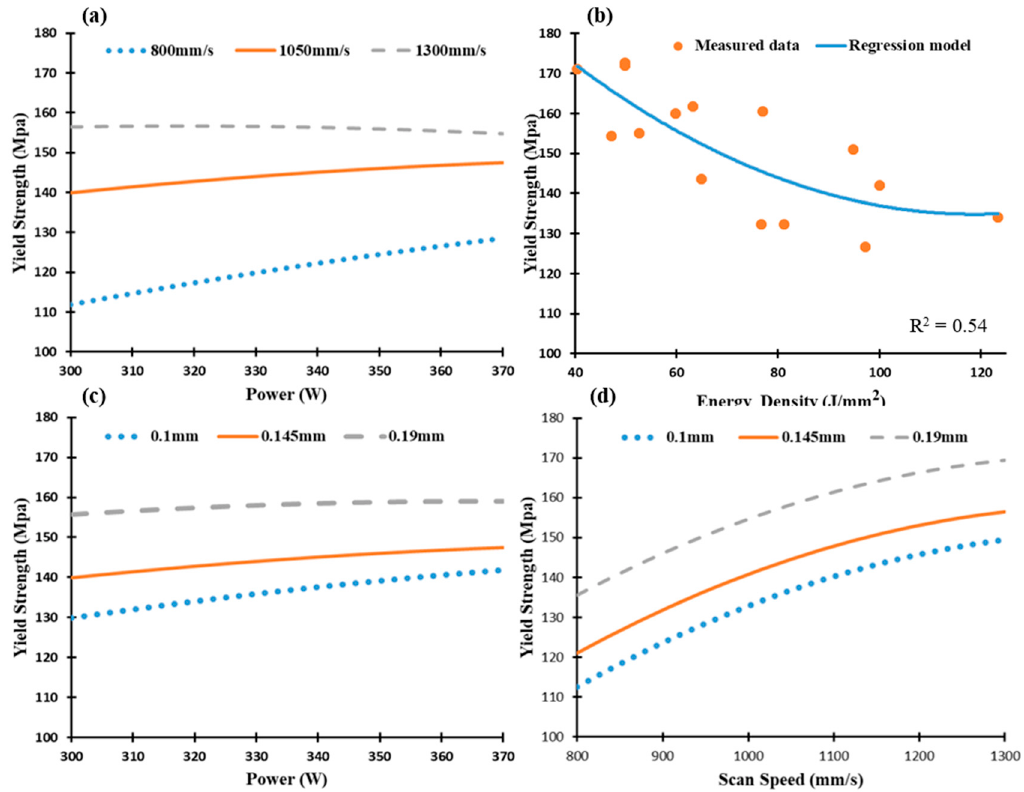
Figure 17. Yield strength of the as-built Al6061 samples vs. ( a ) Laser power (W); ( b ) Energy density (J/mm 3 ); ( c ) Hatch Spacing (mm), and ( d ) Scan speed (mm/s).